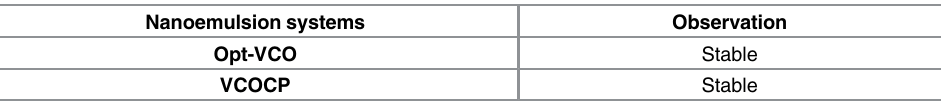
Table 8. Centrifugation